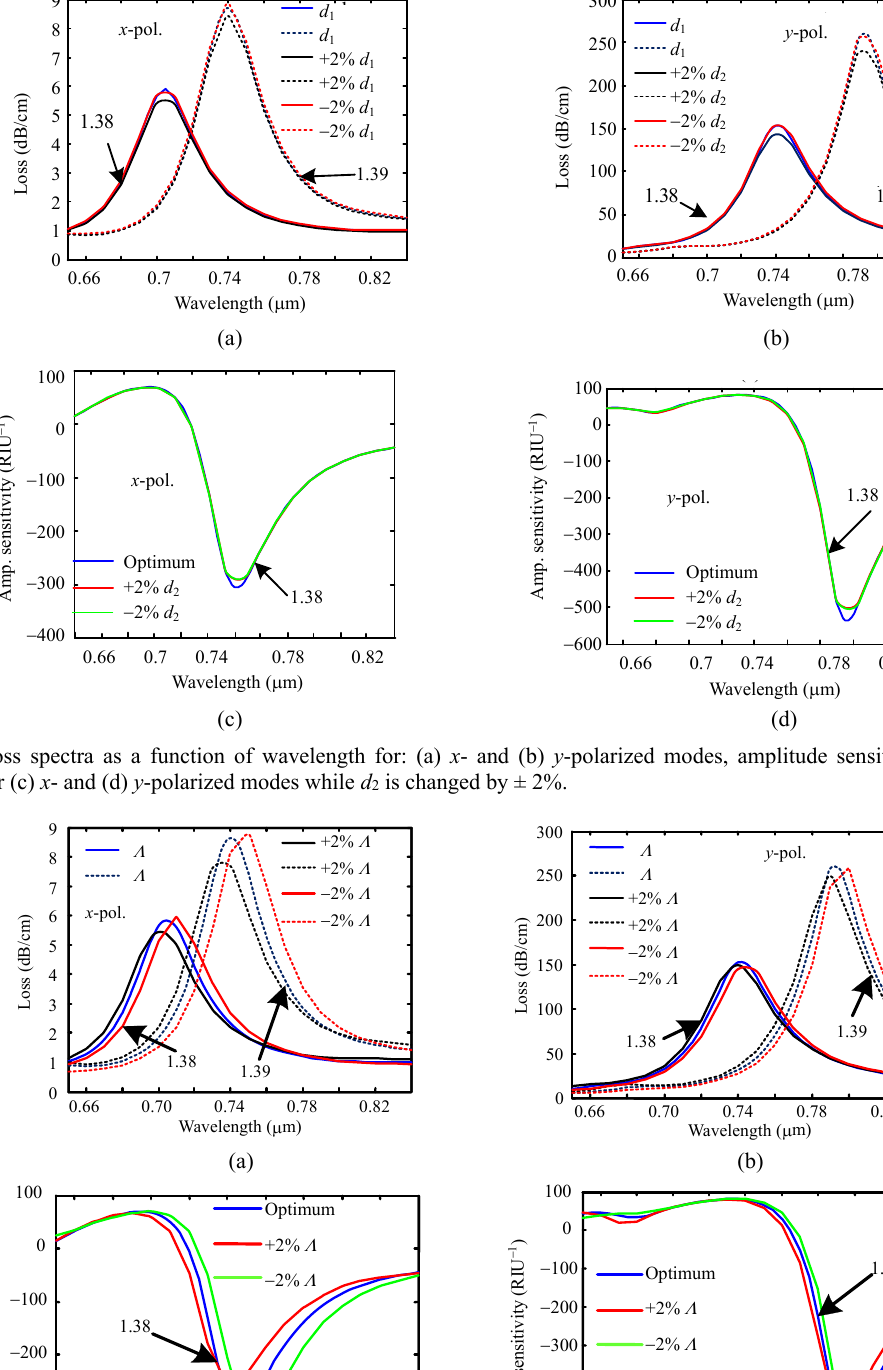
Fig. 11 Loss spectra as a function of wavelength for: (a) x - and (b) y -polarized modes, amplitude sensitivity as a function of wavelength for (c) x - and (d) y -polarized modes while  is changed by ±